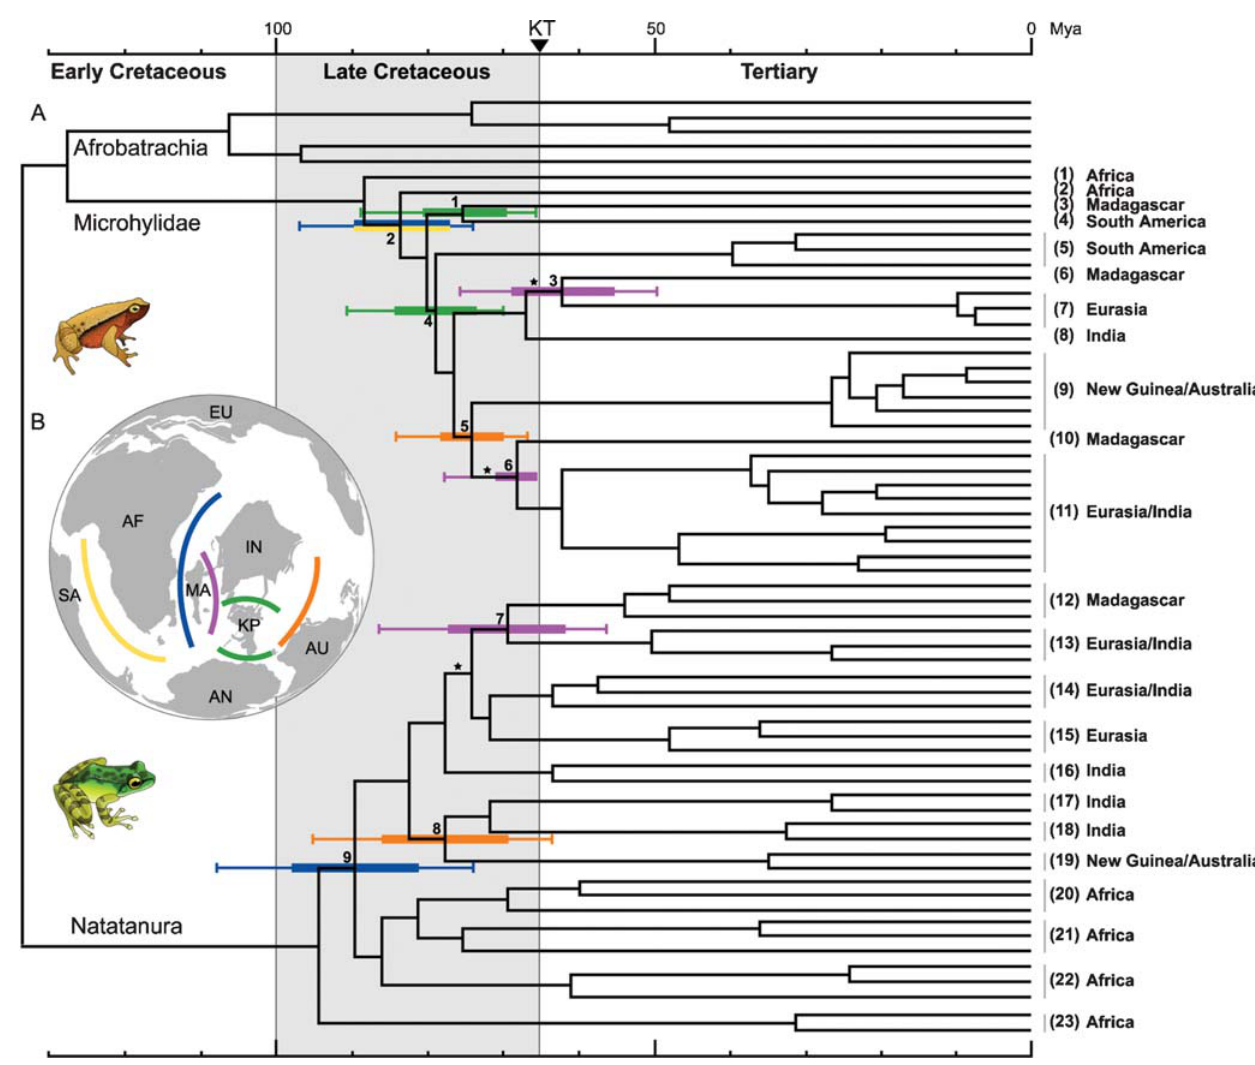
Figure 2. Late Cretaceous vicariance in Microhylidae and Natatanura. ( A ) Molecular timetree (TK method, all calibration points except G [12]). Horizontal colored bars and lines at internal nodes (Standard deviation and 95% credibility interval, respectively) indicate vicariance events reconstructed by DIVA-analyses, and interpreted as follows: orange: Australia , – . Indo-Madagascar; yellow: Africa , – . South America; blue: Africa , – . Indo-Madagascar; purple: Madagascar , – . India (Seychelles); green: S. America-Antarctica , – . Indo-Madagascar (the intervening Kerguelen Plateau being involved). The latter splits in our timetree are interpreted as vicariance events between the Kerguelen plateau and Antarctica or Indo- Madagascar [12]. The branches denoting the latest colonization of Eurasia, as reconstructed by DIVA, are indicated by an asterisk. Numbers at terminals correspond to taxon numbers in figure 1. ( B ) Late Cretaceous Gondwana, with indication of corresponding geological break-ups. Abbreviations: AF=Africa, MA=Madagascar, IN=India, EU=Eurasia, SA=South America, AN=Antarctica, AU=Australia-New Guinea, KP=Kerguelen Plateau.